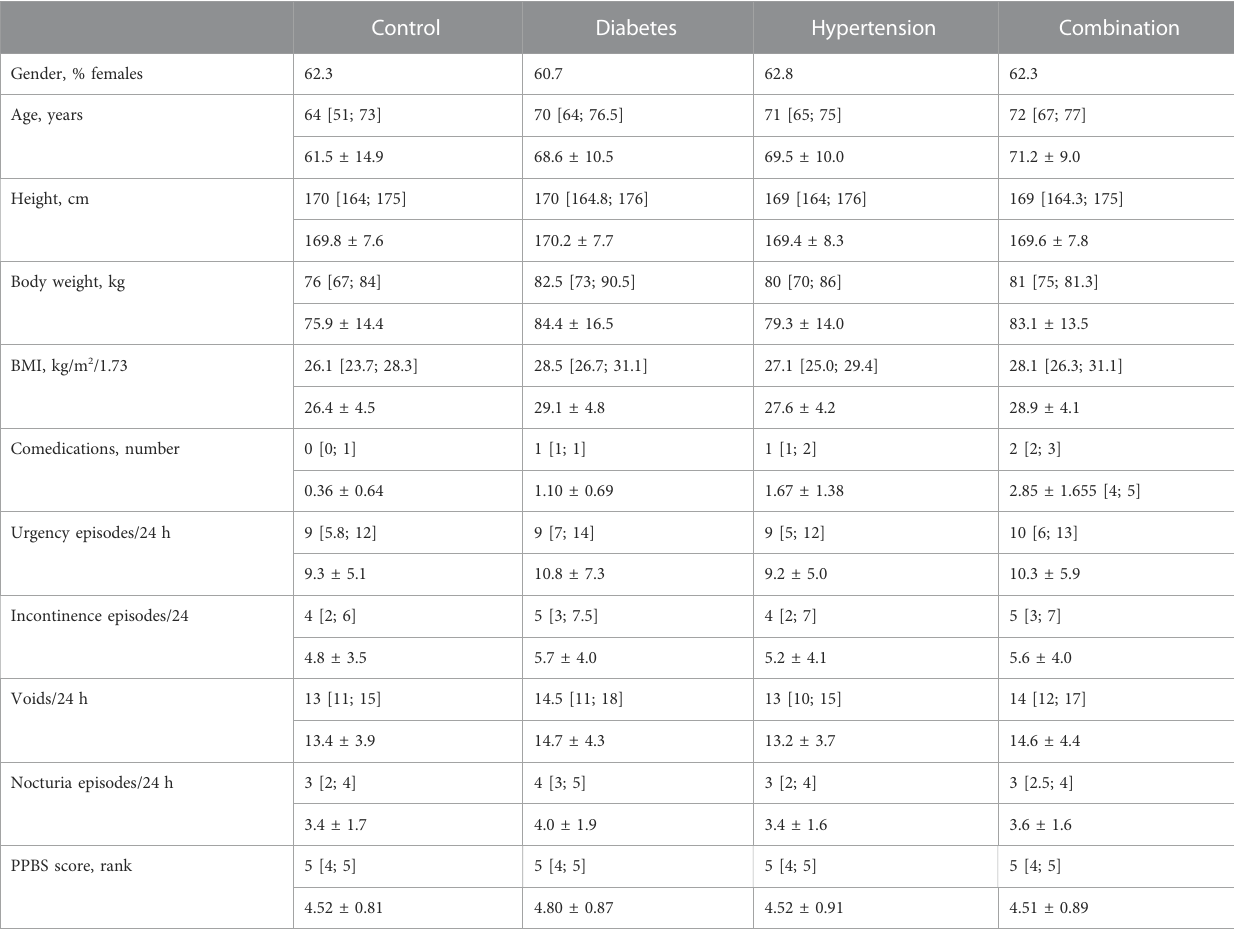
TABLE 2 Demographics and baseline data from study II Data are shown as medians with inter-quartile ranges and as means ± SD in parentheses except for categorical variables that are shown as % of cohort. Data on baseline symptoms are shown only for those exhibiting a pathological value at